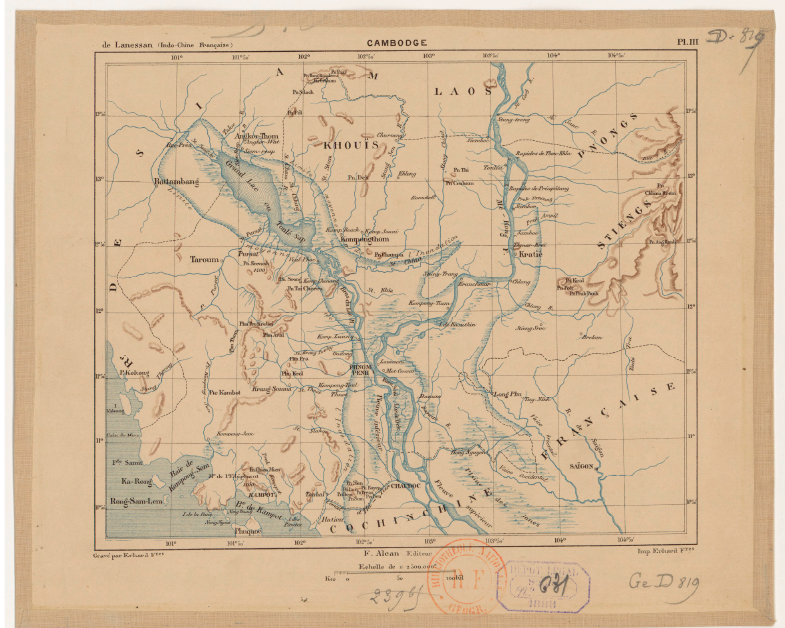
Figure 10. The Tonle Sap’s flooding area was transformed and confined by the progressive buildup of national roads and urban development projects (from the French colonial era until today). (Lanessan, Jean-Louis de (1843–1919). Cartographe. Cambodge/de Lanessan; gravé par Erhard Frères. 1888).